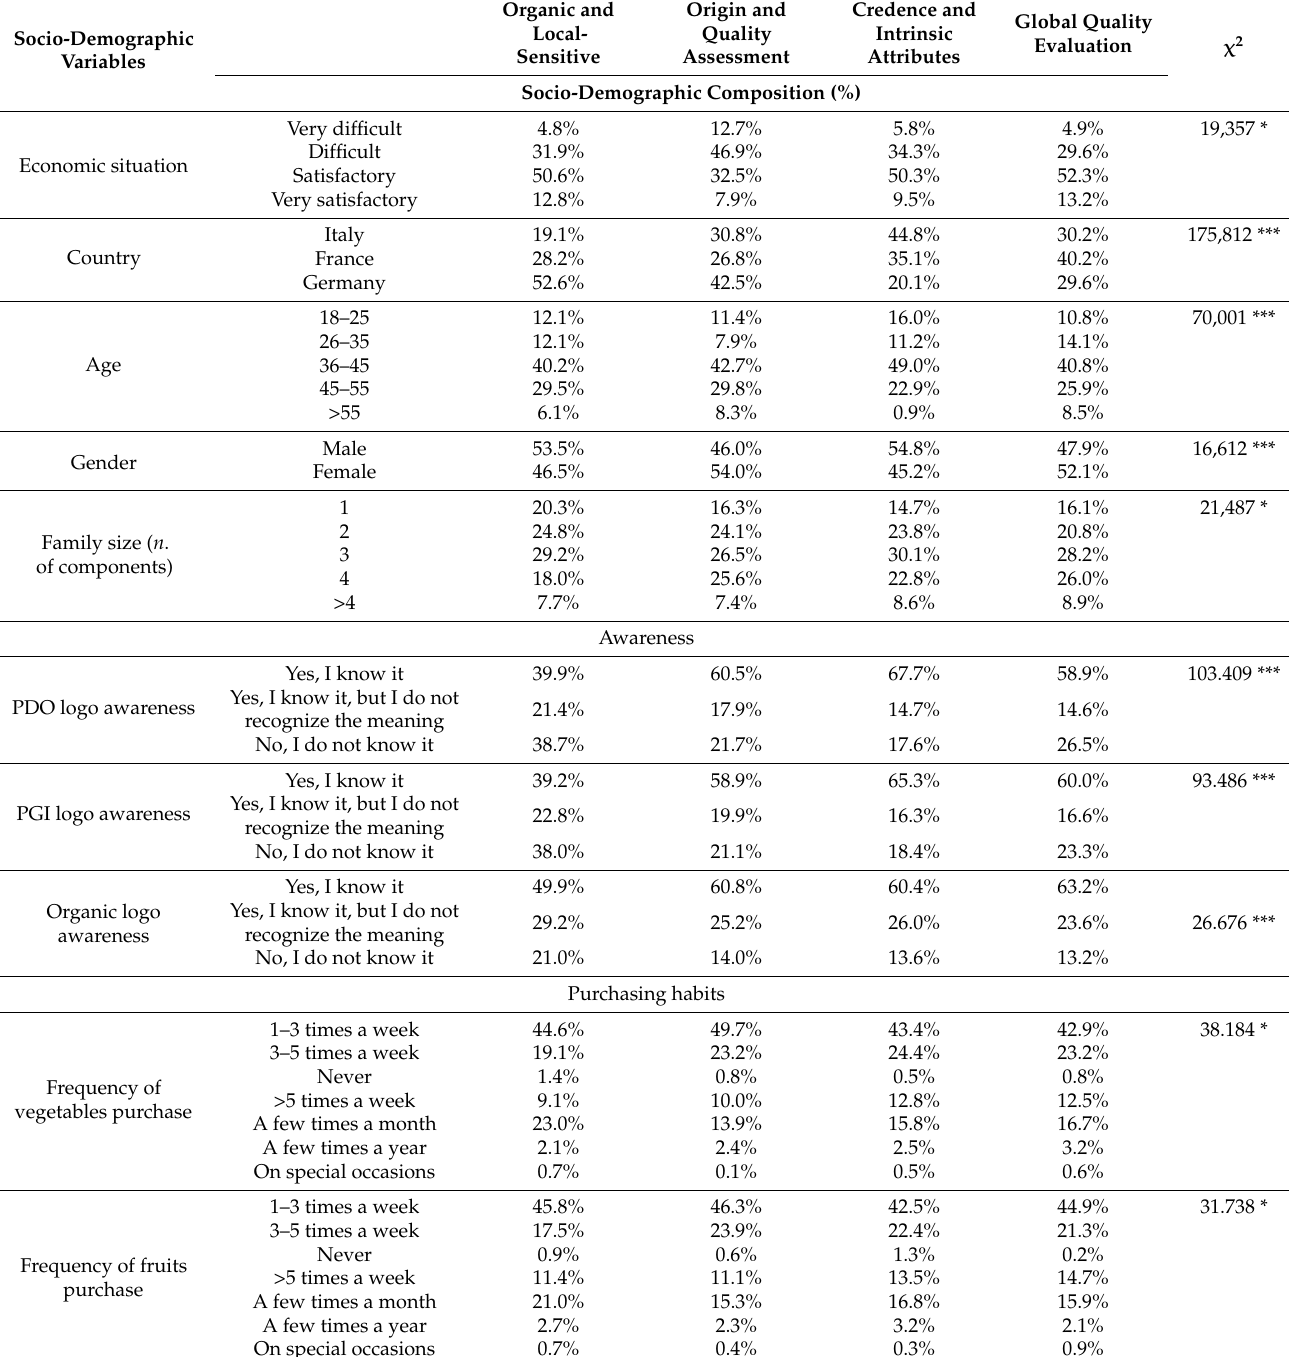
Table 5. Cluster